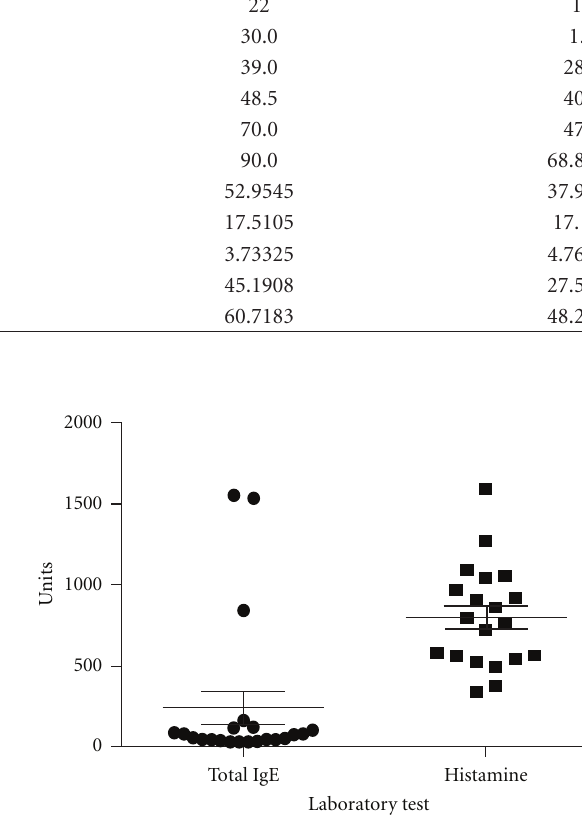
Figure 4: Frequency distribution of serum IgE level and whole blood Histamine levels in the group. Mean IgE level was 213 IU/mL and and Median was 37 IU/mL. Mean Histamine level was 798 nmol/L. Data was available for 22 and 20 patients, respectively.